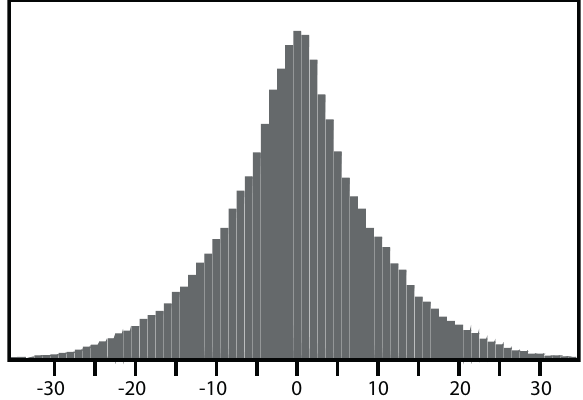
Fig. 2. Distribution of difference of positions between the closest maximas and between the closest minimas (i.e. coherent structures) in the 10000 coupled forecasts.